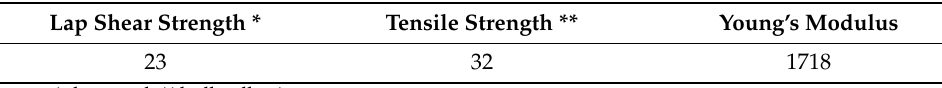
Table 1. Loctite EA 9466 mechanical properties (in MPa). Lap Shear Strength